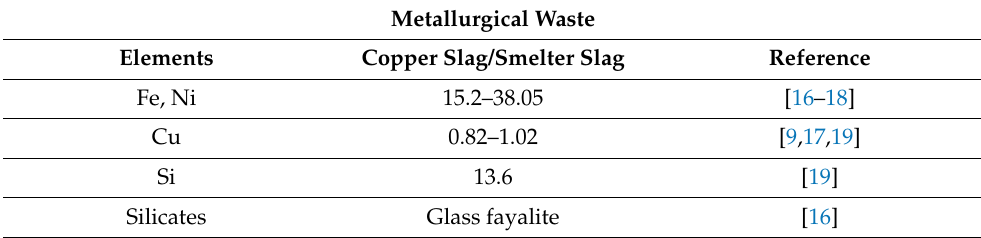
Table 1. Phase and chemical composition of copper